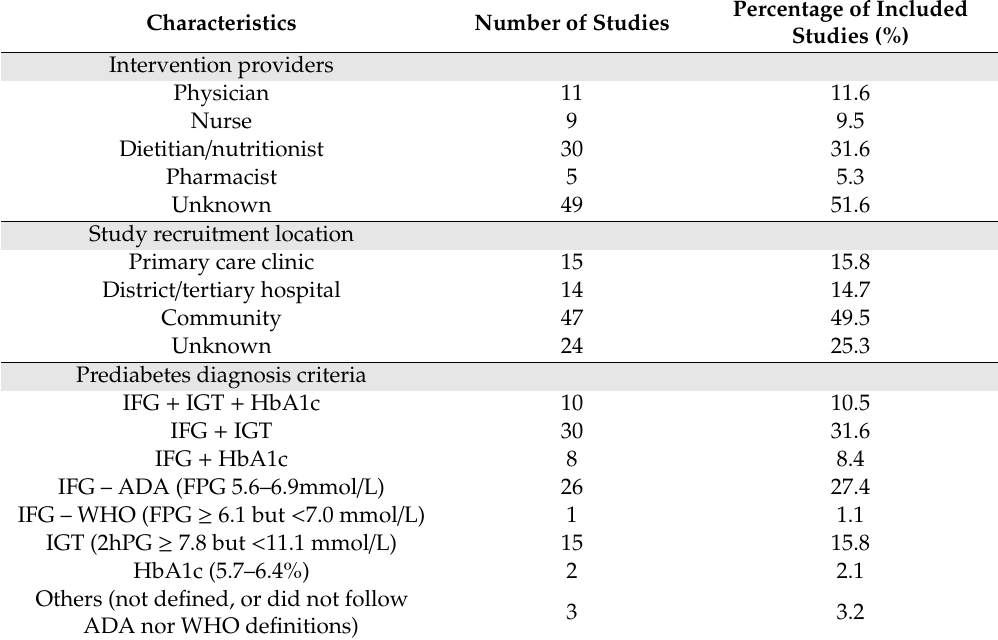
Table 2. Intervention characteristics.